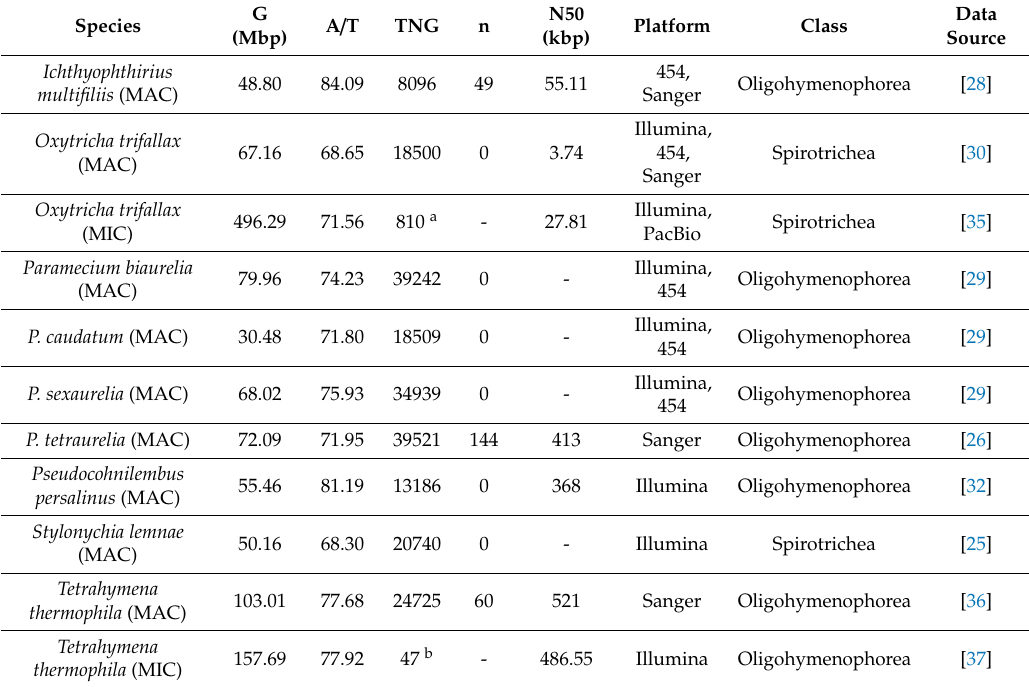
Table 1. Features of macronuclear and micronuclear genomes analyzed in this study.